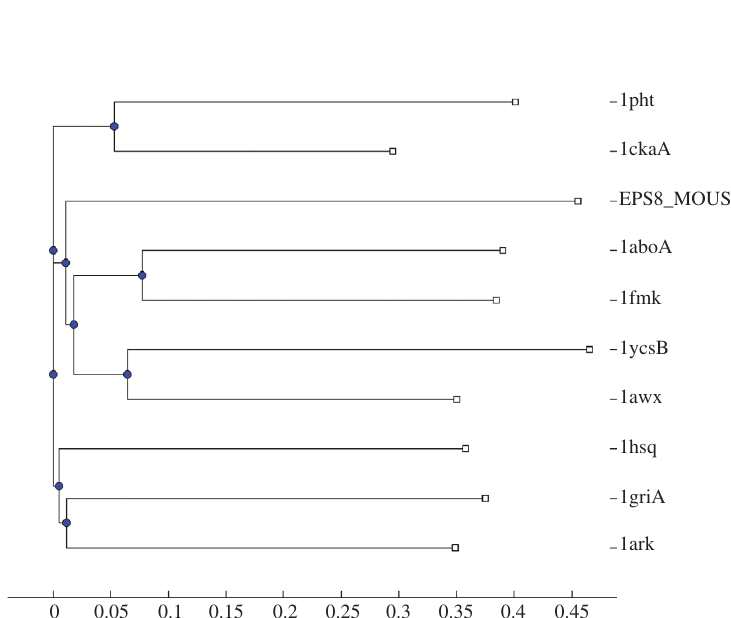
Figure 3. The Guide Tree of the Sequences.